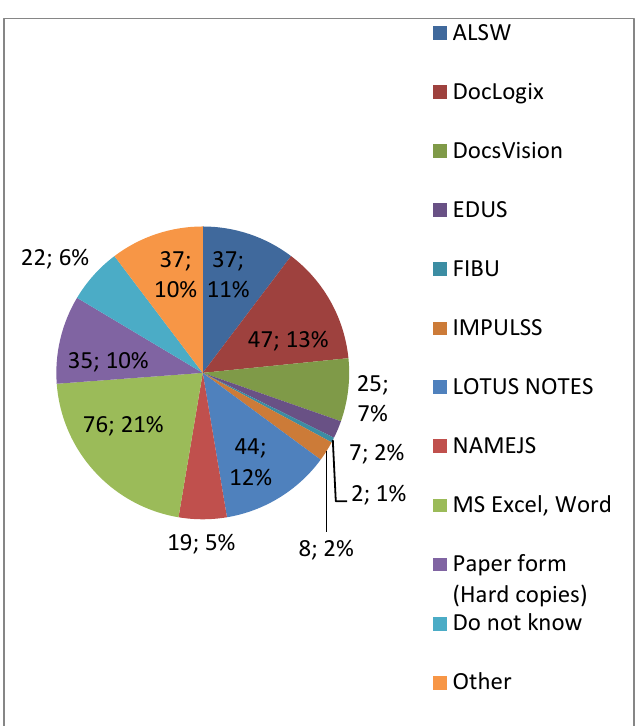
Fig. 8. The use of IS for development, use and storage of ND and processes.